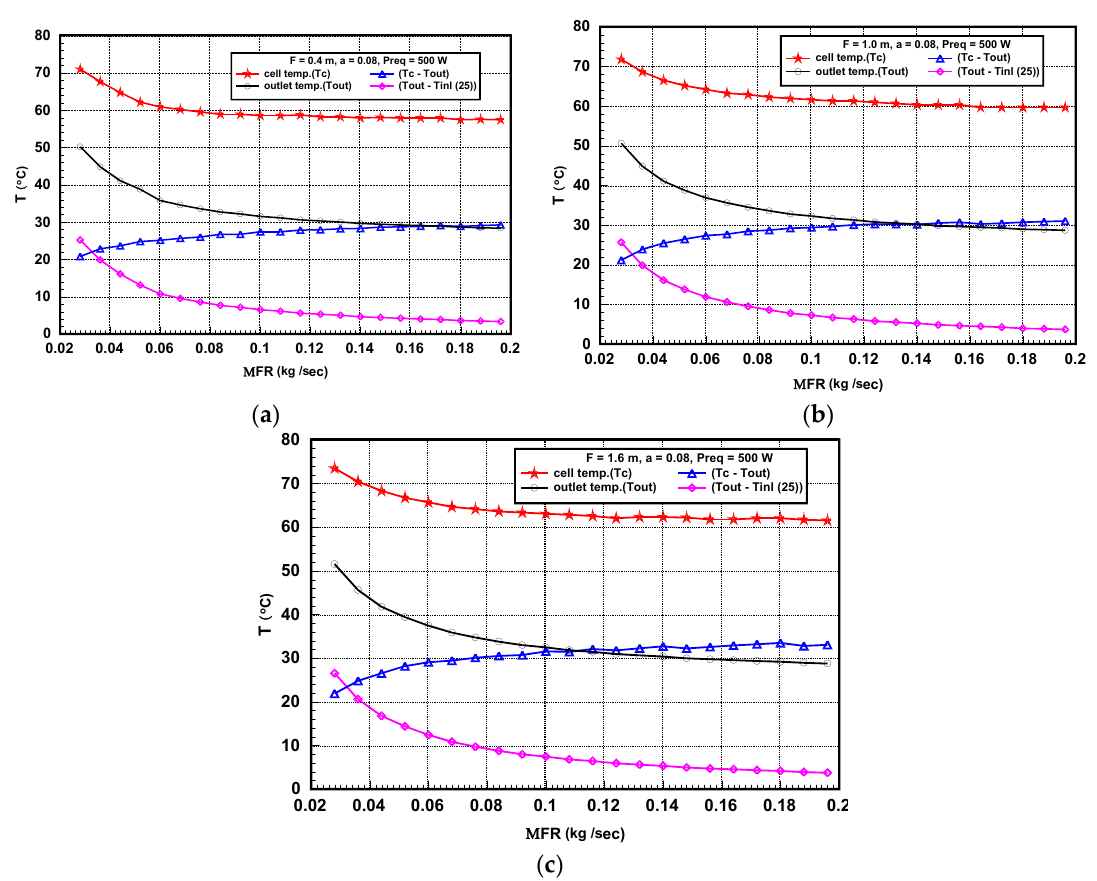
Figure 18. Effective temperatures of a CPVT collector plotted against the mass flow rate for the same required power and receiver width, ( a – c ) various focus distances.